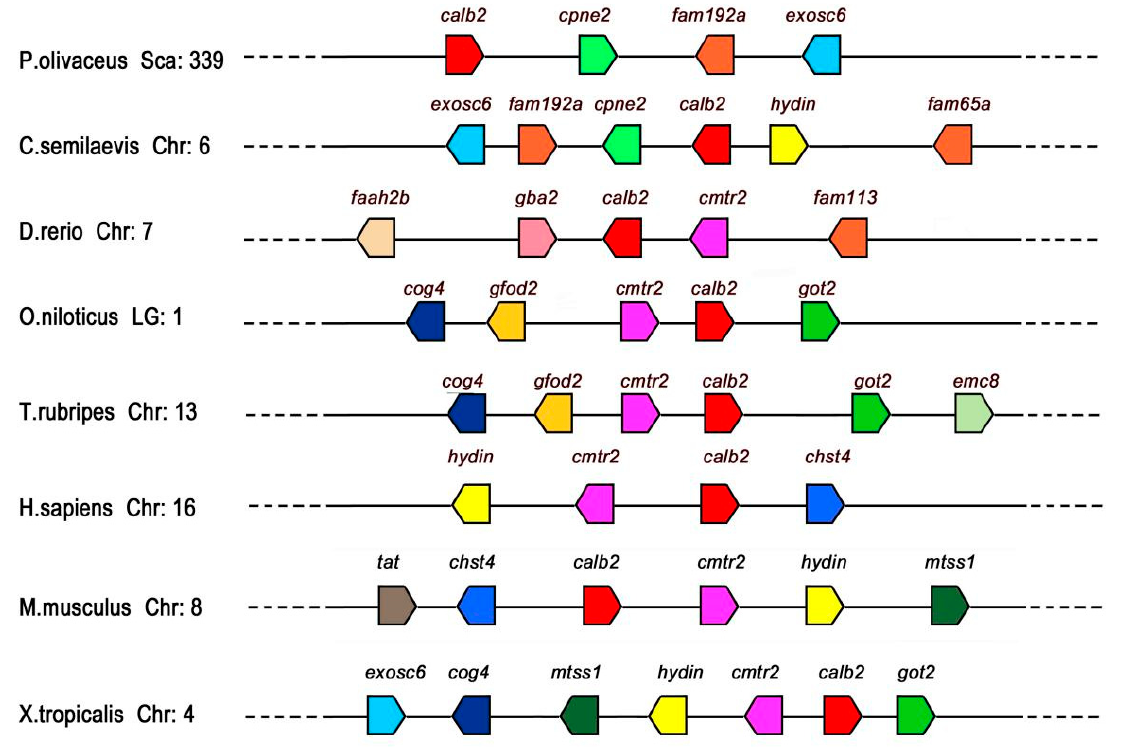
Figure 4. Synteny maps for the P. olivaceus calb 2 on the scaffold and its counterparts from other vertebrate chromosomes constructed using the Ensembl Genome Browser (http://www.ensembl.org). The bar lengths are not proportional to the distances between genes. Gene symbols were determined by Browser. The direction of the arrows indicates the gene orientation. Chr, chromosome; LG, linkage group; Sca, scaffold.